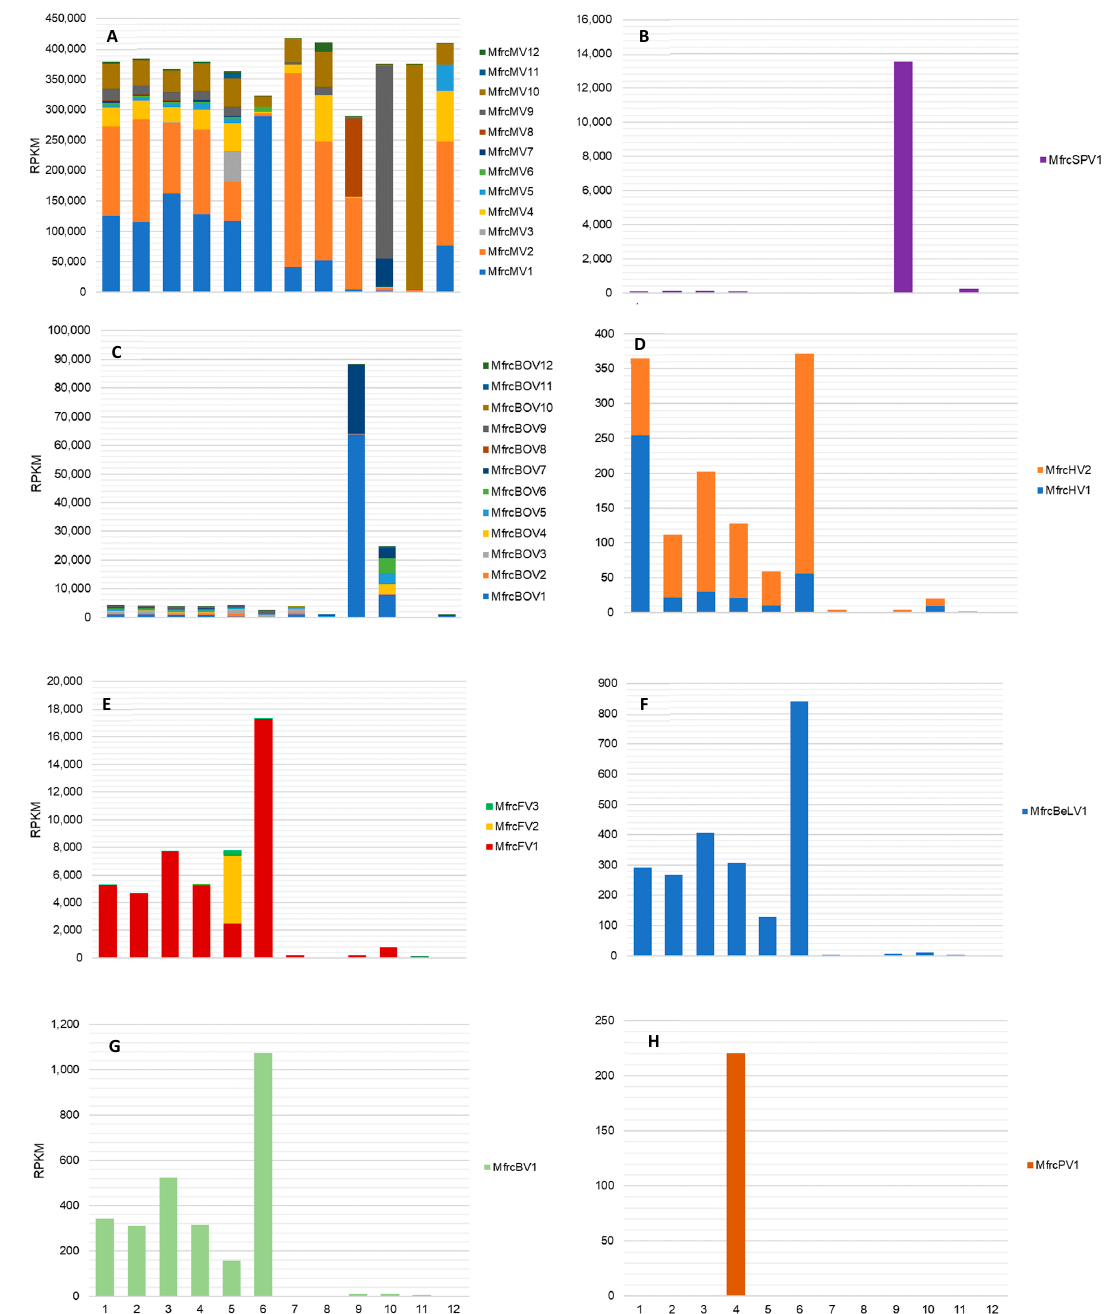
Figure 7. Detection rate of viral families and single viruses in 12 pools of Monilinia fructicola isolates in RPKM (reads normalized per kilobases of viral genome length and millions of total reads mapped on the virome). ( A ) Mitoviriridae ; ( B ) Splipalmiviridae ; ( C ) Botourmiaviridae ; ( D ) Hypoviridae ; ( E ) Fusariviridae ; ( F ) Benyviridae ; ( G ) Barnaviridae ; ( H ) Parvoviridae .